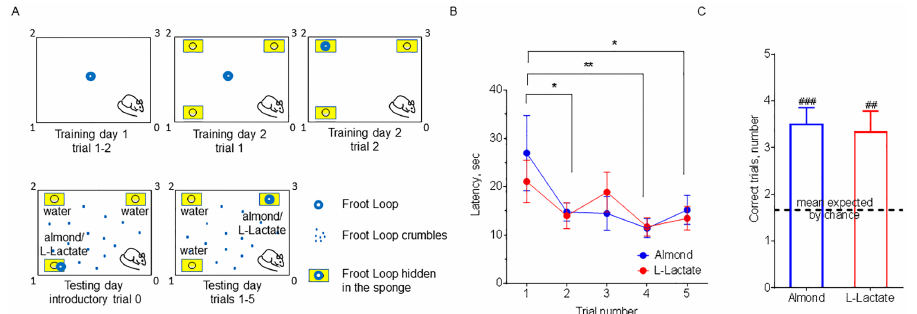
Fig 2. Rats are able to discriminate the odour of L-Lactate. A. Schematic illustration of an odour- reward associative learning task in rats . Duringthe trainingdays, rats were habituatedto the arena and rewardretrieval procedure.During the introductory trial (0) on the testing day (not includedin further analysis), a spongesoaked with the test odorant carried a visiblefood reward. During consequent five trials on the testing day, a randomly placedsponge soaked with the test smell dispenseda hiddenfood reward. Outcomes of odour associative learning task in rats: B . Time taken by rats to find a food reward by the smell (latency) was not different betweenL-Lactateand a positive control, almond.Over the trials the latency to find a food reward decreased for both odorants. Data are shown as mean ± SEM,n = 12. * p < 0.05, ** p < 0.01,two-way ANOVA with Bonferroni’s correction. C . Distributionand mean of correct trials for rats did not differ between L-Lactateand almond.Number of observedcorrect trials was significantlyhigherthan expectedby chance. Data are shown as mean ± SEM,n = 12. ### p < 0.001, ## p < 0.01vs mean expectedby chance, t-test.